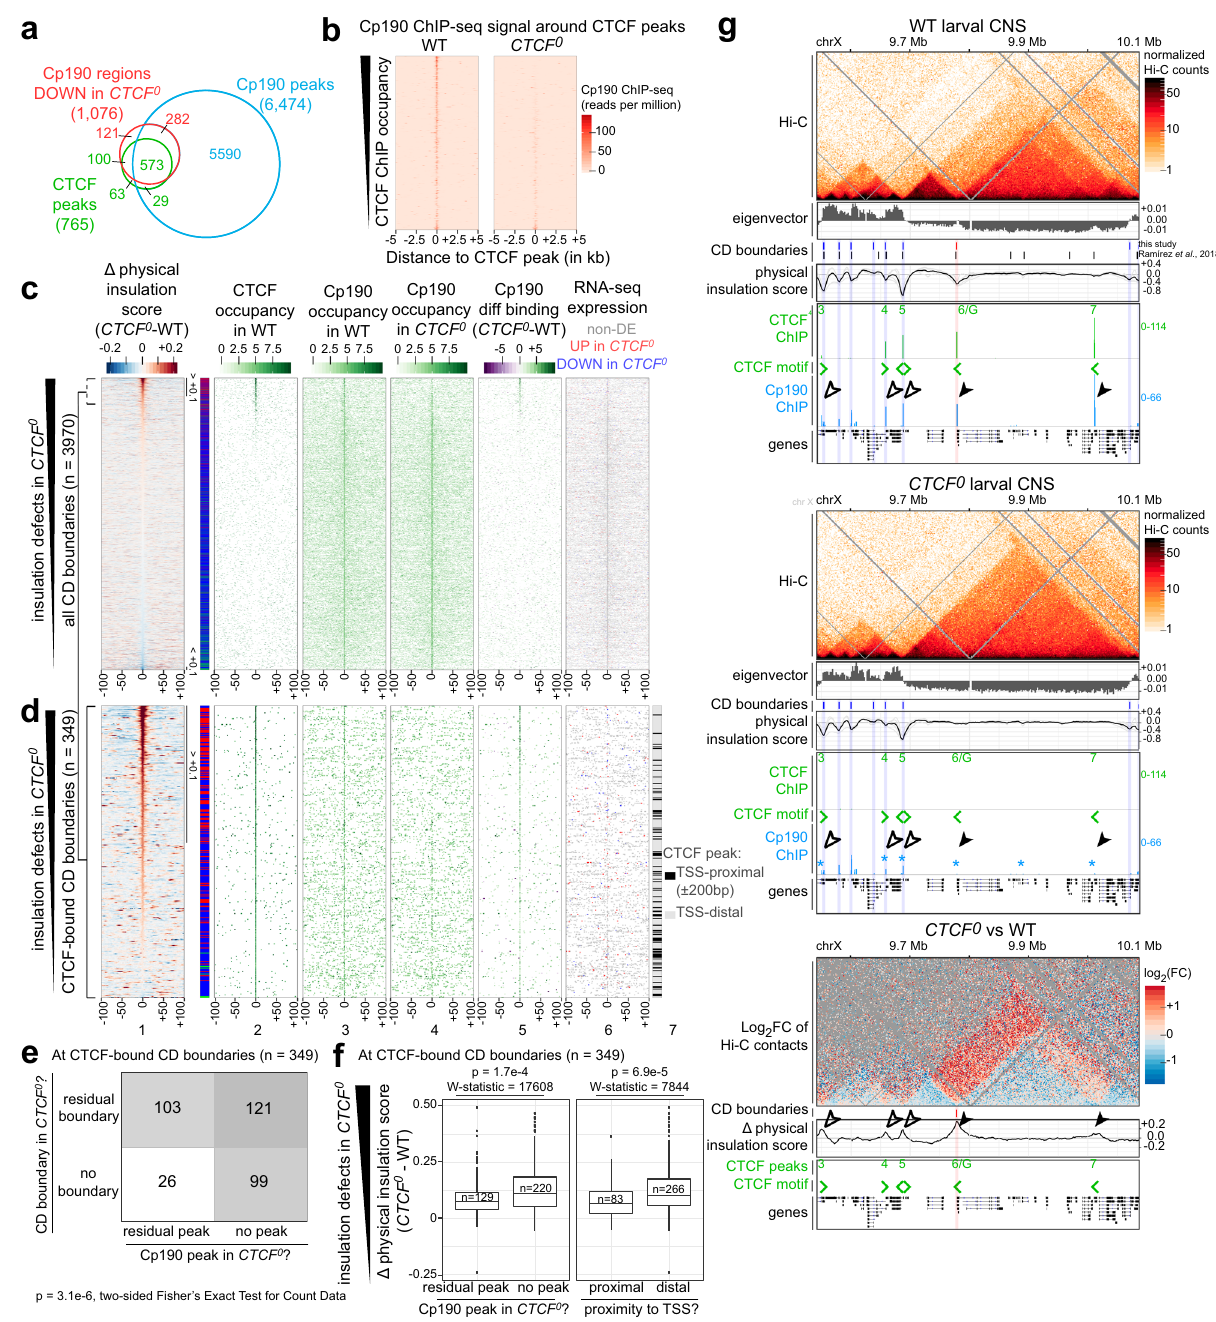
p = 3.1e-6, two-sided Fisher’s Exact Test for Count